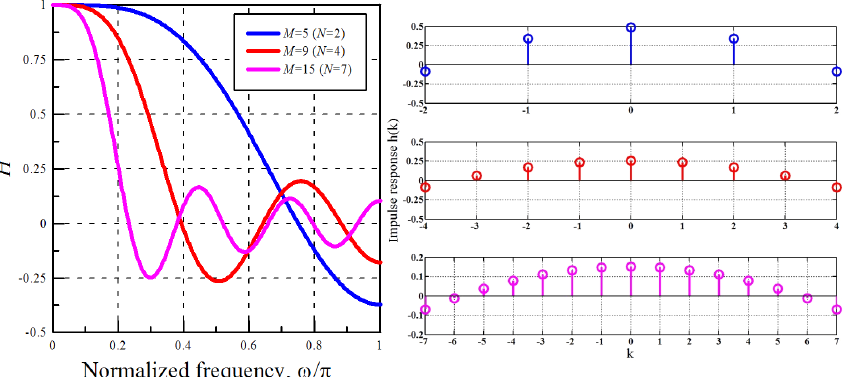
Figure 1. Left panel: frequency responses of the SG2 smoothing filter for different values of the filter length, M = 2 N + 1. Right panel: non-causal impulse responses for the different filter lengths.